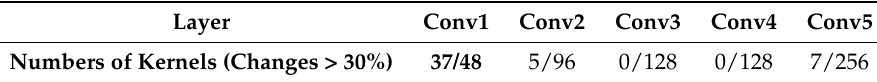
Table 8. Kernel variations in L2-norm of each convolutional layer (primary target